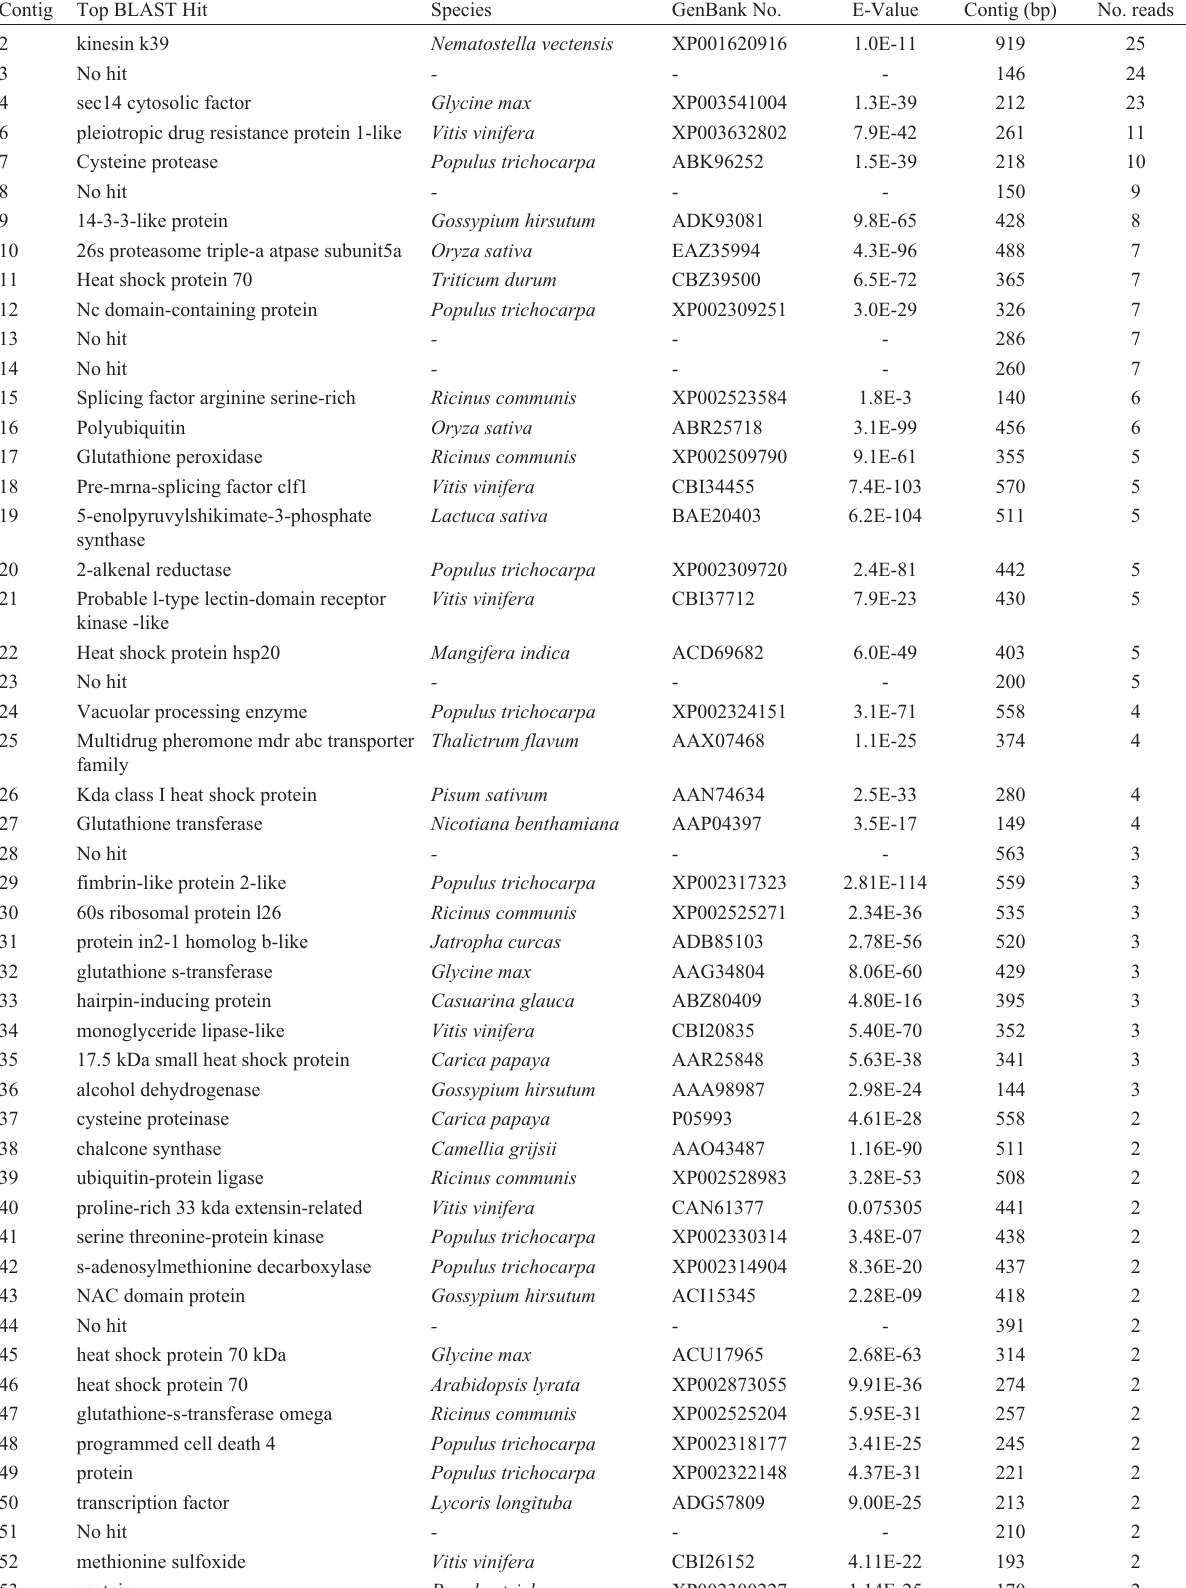
Table 1 - Top BLAST hits of microgravity SSH library assembled contigs containing 2 or more reads. Contig Top BLAST Hit